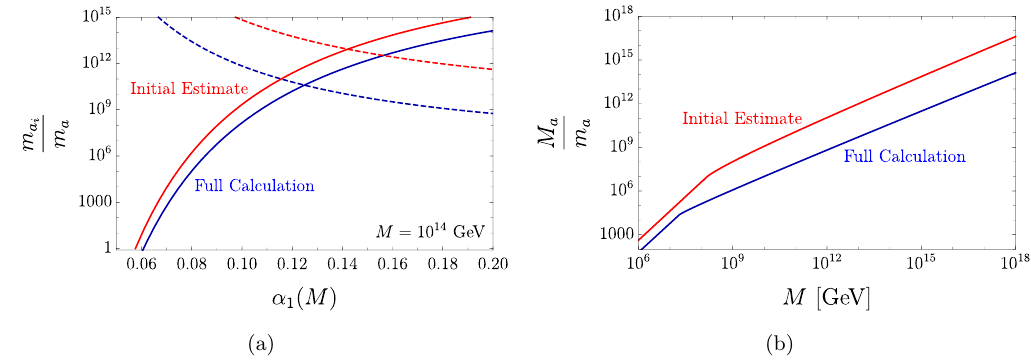
Figure 4 . Small instanton contribution to the axion mass relative to the IR QCD contributions in the model based on the symmetry breaking structure SU(3) (cid:2) SU(3) (cid:2) SU(3) ! SU(3) QCD . On the left we show the results for the full calculation in blue compared to the initial estimates in previous work [12] in red at a breaking scale of M = 10 14 GeV as a function of (cid:11) 1 = g curves show m a =m a ( m a =m a ), which intersect at M a =m a ’ 4 (cid:1) 10 10 in the full calculation and 1 2 at M a =m a = 9 (cid:1) 10 12 in previous estimates. On the right we show the values for M a =m a at the intersection point of m a =m a and m a =m a or at the maximum of m a 1 2 for a wide range of breaking scales M . In both plots we took f a g 2 = g 3 , which implies that m a is always slightly larger than m a 3